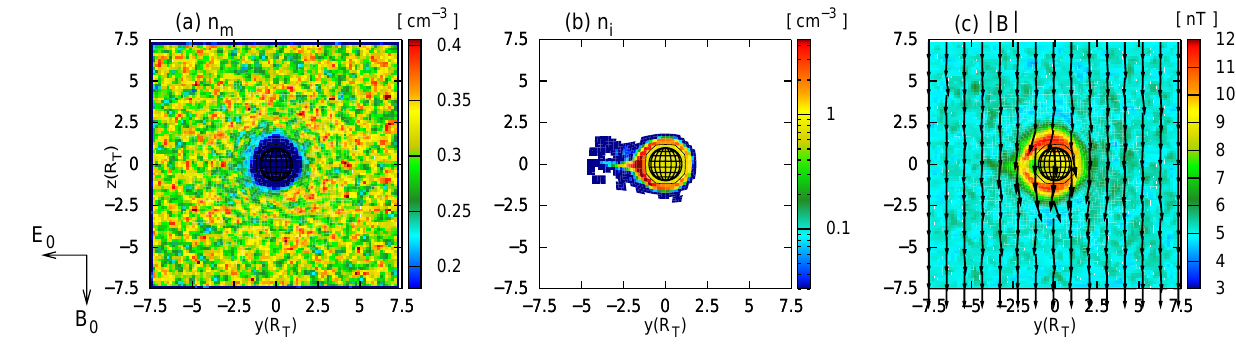
Fig. 9. Interaction of Titan’s ionosphere with the subsonic Saturnian magnetospheric plasma at 18:00 local time. The figure displays the results for a cut through the (y,z) plane of the simulation box which coincides with Titan’s terminator plane. The undisturbed magnetospheric plasma flow is directed in ( + x) direction, i.e. out of the paper plane. The background magnetic field B 0 is orientated antiparallel to the z axis and thus, the convective electric field E 0 points in ( − y) direction. The figure displays (a) the magnetospheric ion density n m , (b) the ionospheric ion density n i and (c) the magnetic field. Again, the arrows denote the projection of the field vectors in the cutting plane. Since the upstream plasma flow is subsonic, no bow shock is formed in front of the obstacle. As in the case of a supersonic flow, the obstacle’s ionospheric tail is more extended in the E + hemisphere than in the E − hemisphere. Due to Saturn’s intrinsic magnetic field being draped around the obstacle, a magnetic pile-up region which is characterized by an increased field strength arises in the immediate vicinity of Titan.